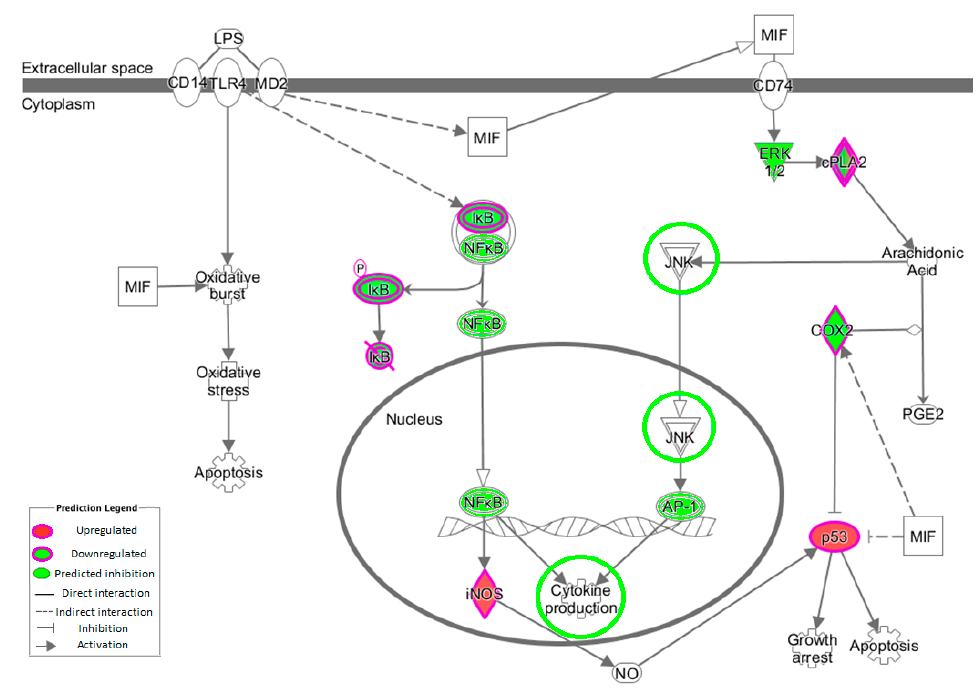
Figure 3. Macrophage migration inhibitory factor (MIF) regulation of innate immunity canonical pathway. Cytokine production is circled in green because there are several related cytokines, including IL-8 ( − 2.4 FC) and oncostatin M ( OSM ) ( − 1.43 FC), which were downregulated with OLE consumption.